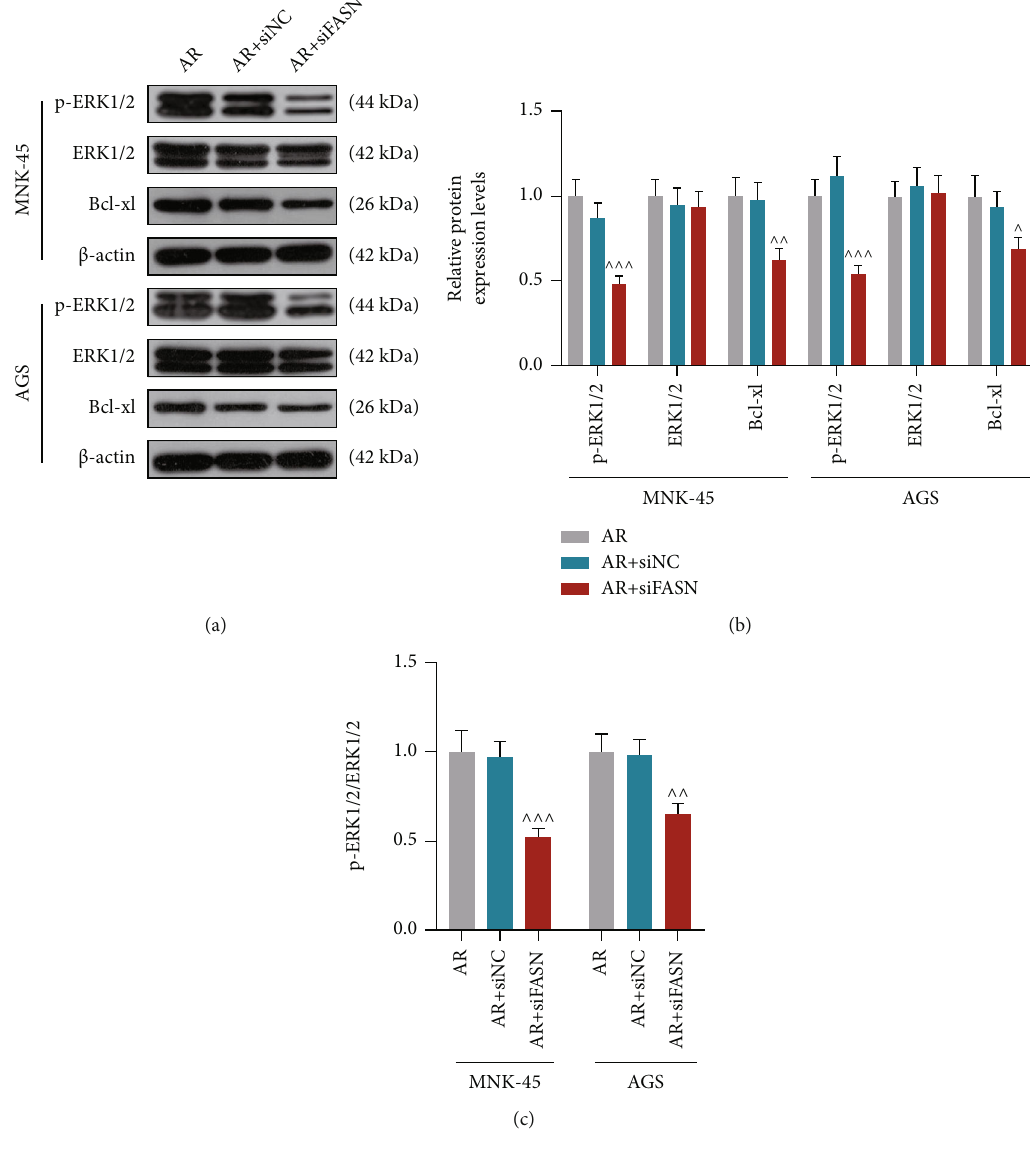
Figure 5: Small interfering RNA targeting fatty acid synthase (siFASN) signi fi cantly suppressed p-ERK1/2/Bcl-xL pathway activation in anoikis resistant gastric cancer cells. (a) Representative pictures of the protein levels of phosphorylated (p)-ERK1/2, ERK1/2 and Bcl-xL in MNK-45 and AGS cells in the anoikis resistance (AR), AR +small interfering RNA negative control (siNC), AR + siFASN groups during western blot. β -Actin was used as a loading control. (b) Quantitative analysis of p-ERK1/2, ERK1/2 and Bcl-xL expressions normalized to β -actin through western blot. (c) The Relative ratio of p-ERK1/2 to ERK1/2 expression. ^ p < 0.05 vs. AR + siNC group; ^^ p < 0.01 vs. AR +siNC group; ^^^ p < 0.001 vs. AR +siNC. Data were performed as the means ±